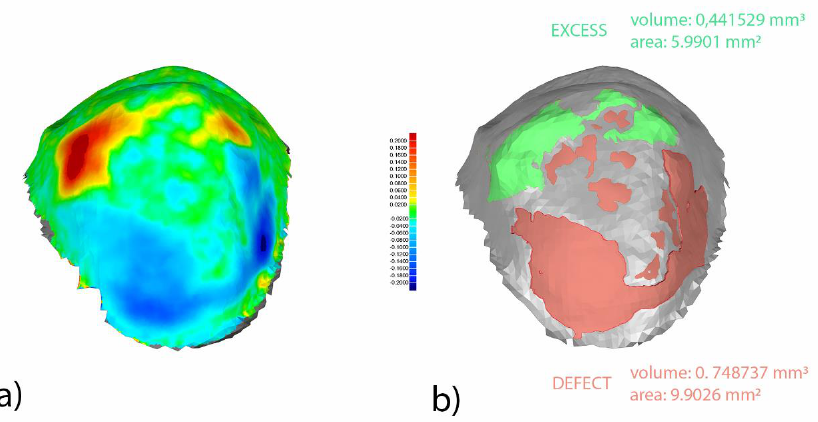
Figure 4. Palatal view of segmented and realigned STL1 and STL3 digital files from tooth 1.5. Warm colors represent a volume increase (remaining cement after cement polishing), cold colors represent a volume decrease (enamel removed after cement polishing), and green represents accurate alignment ( a ). Boundary for the area and volume measurement of the remaining cement after cement polishing (green) and enamel removed after cement polishing (red) ( b ). Current values expressed in millimeters.